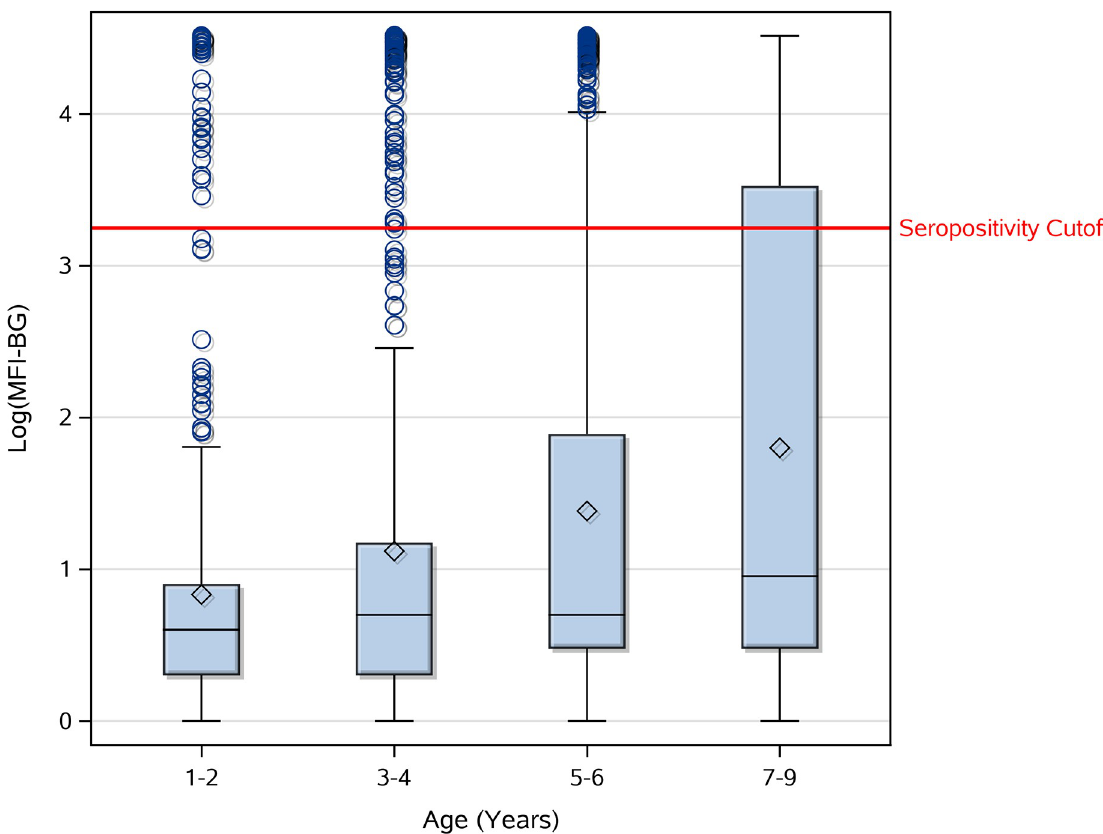
Fig 2. Anti-Pgp3 antibody levels [log(MFI-BG)] by age. The horizontal line within each box represents the median, and the diamond represents the